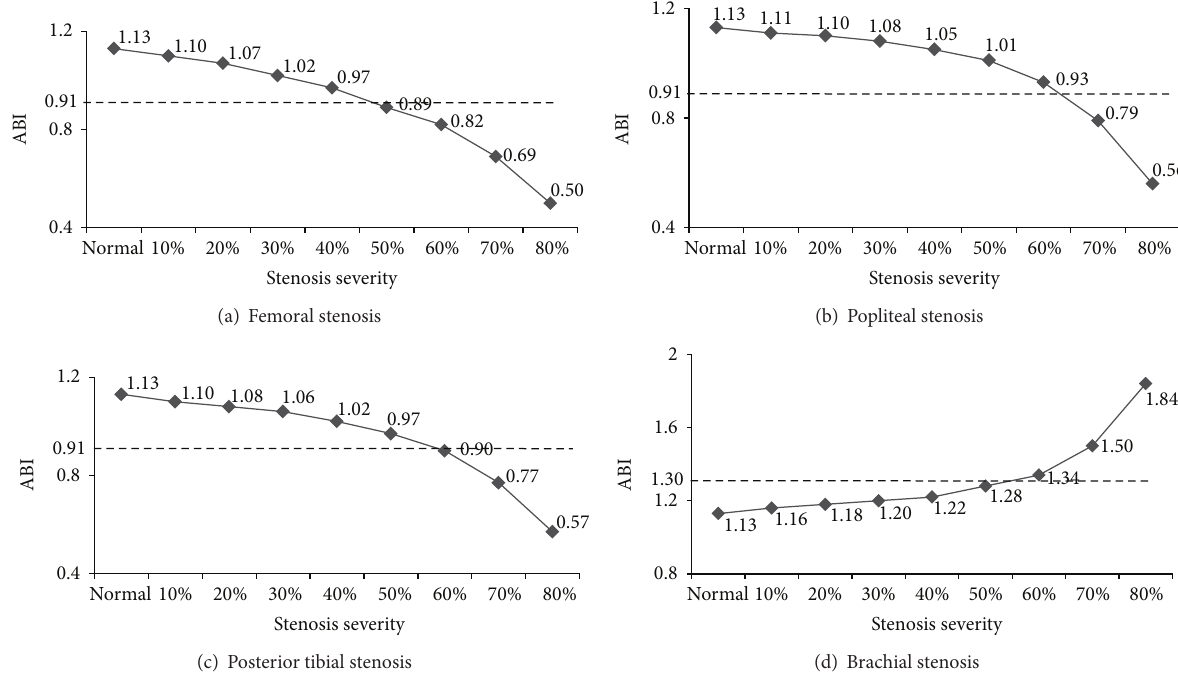
Figure 7: Changes of ABI value with stenosis increased from 0% to 80% at 4 arteries, respectively. (a) variation tendency of ABI with femoral stenosis; (b) variation tendency of ABI with popliteal stenosis; (c) variation tendency of ABI with posterior tibial stenosis; (d) variation tendency of ABI with brachial stenosis. The dotted line in each figure represents the evaluation standards of normal ABI (0.91 ∼ 1.30) which is used as the threshold for stenoses diagnosis in clinical